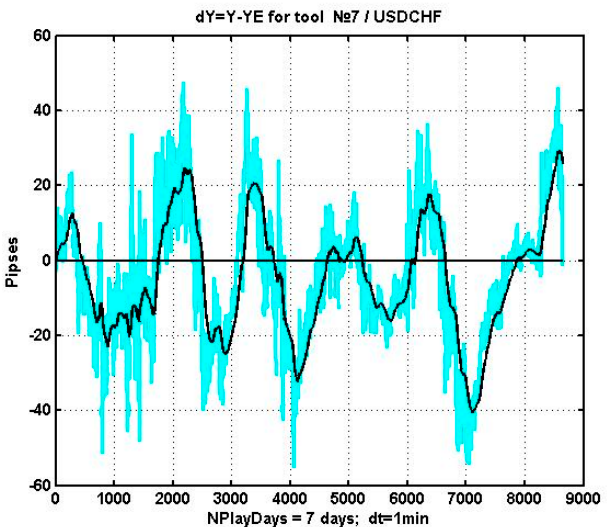
Figure 5. Difference and smoothed difference between USDCHF and the regression estimates.